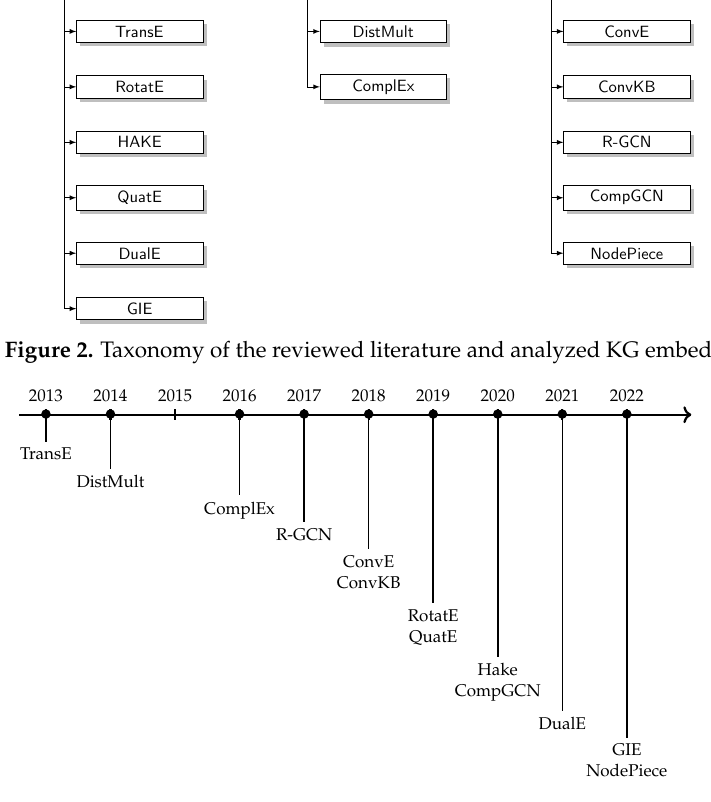
Figure 3. Publication timeline